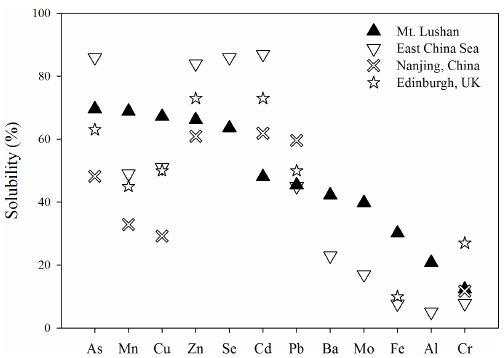
Figure 7. Comparison of element solubility for aerosol at Mt. Lushan (PM 2 . 5 , this study), the East China Sea (TSP, NE NAD group, Hsu et al., 2010), Nanjing, China (PM 2 . 5 , Hu et al., 2012), and Edinburgh, UK (PM 2 . 5 , urban background site, Heal et al.,